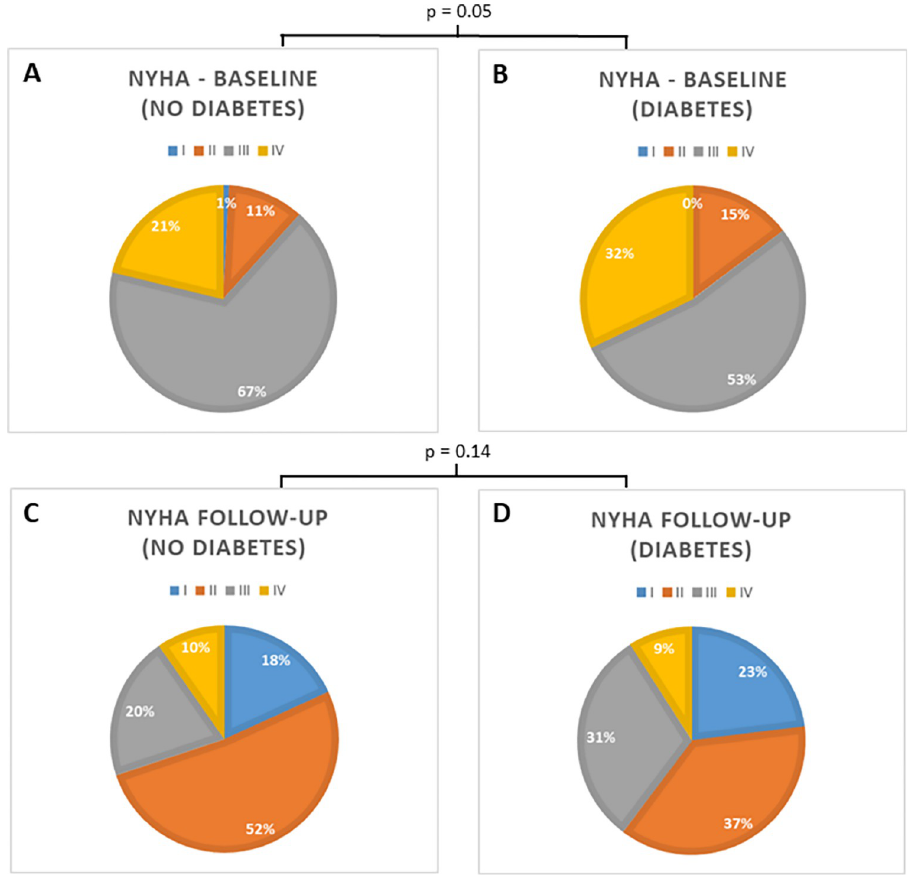
Fig 2. New York Heart Association (NYHA) class at baseline and at one-year follow-up. The upper panels (A and B) show NYHA class at baseline and the lower panels (C and D) at one-year follow-up in patients without (A and C) und with diabetes mellitus (B and